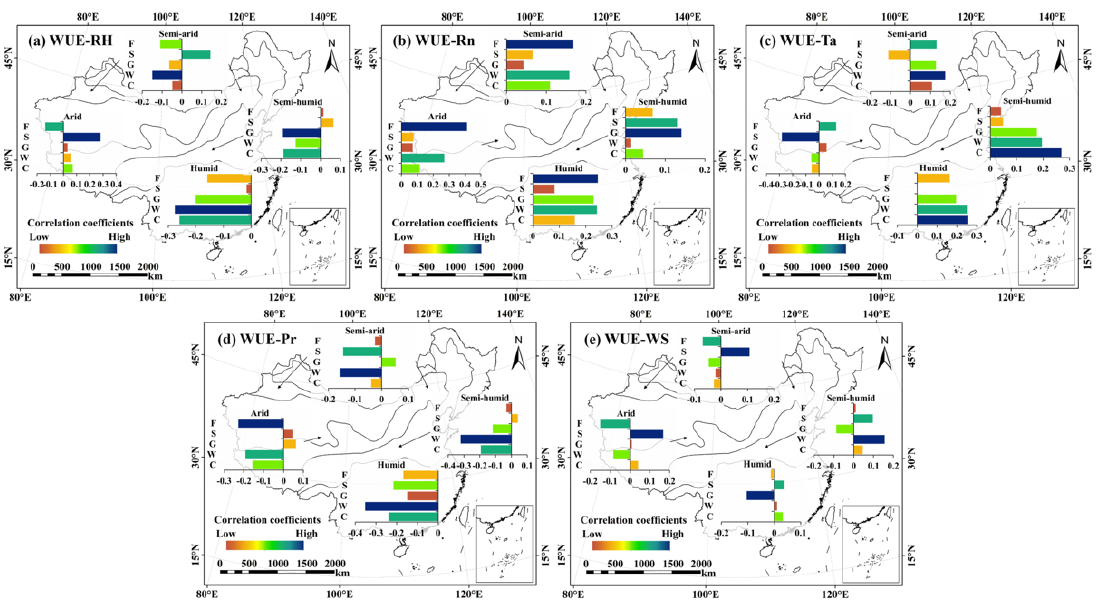
Figure 14. Average correlation coefficients between WUE and climatic factors for each vegetation type in four arid-humid zones from 2001 to 2021. ( a ) Relative Humidity (RH); ( b ) Net radiation (Rn); ( c ) Average temperature (Ta); ( d ) Precipitation (Pr); ( e ) Wind Speed (WS). F: forest; S: shrubland; G: grassland; W: wetland; C: cropland.